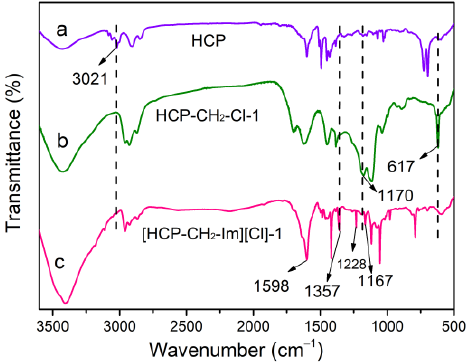
Figure 2. FT-IR spectra of ( a ) HCP, ( b ) HCP-CH 2 -Cl-1, and ( c ) [HCP-CH 2 -Im][Cl]-1.